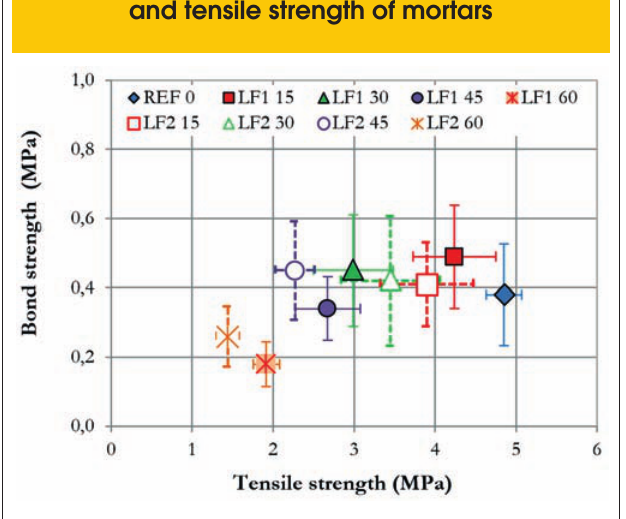
Figure 8 – The relation between bond strength and tensile strength of mortars